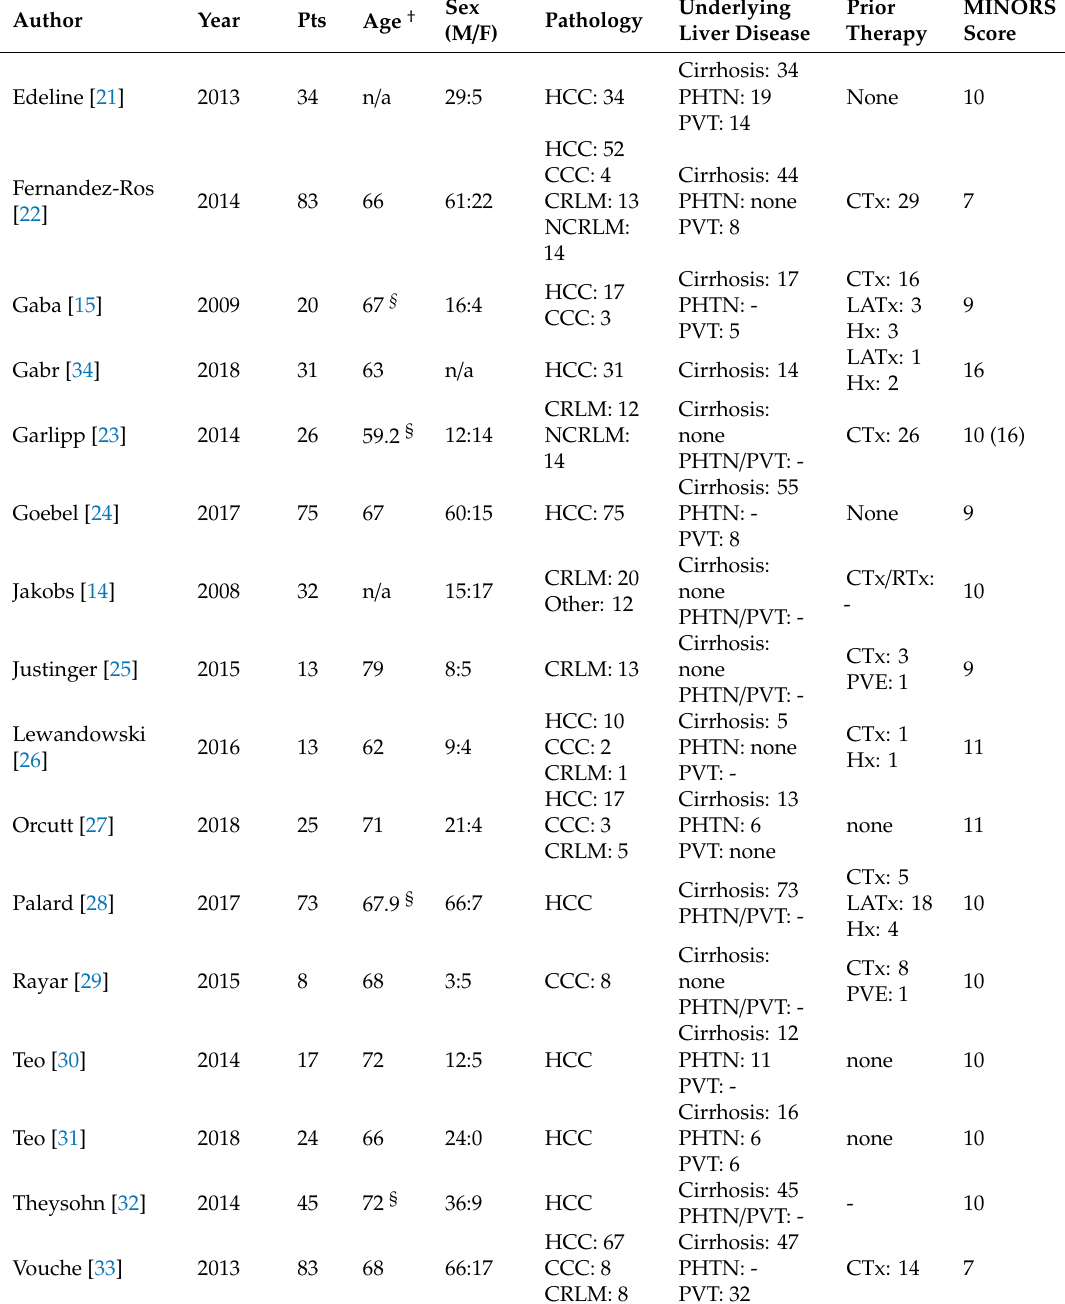
Table 1. Baseline characteristics of patients in included